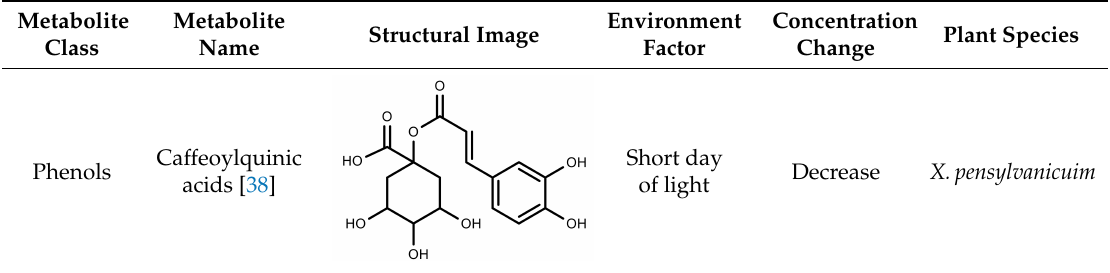
Table 1. Photoperiod change on the content of various plant